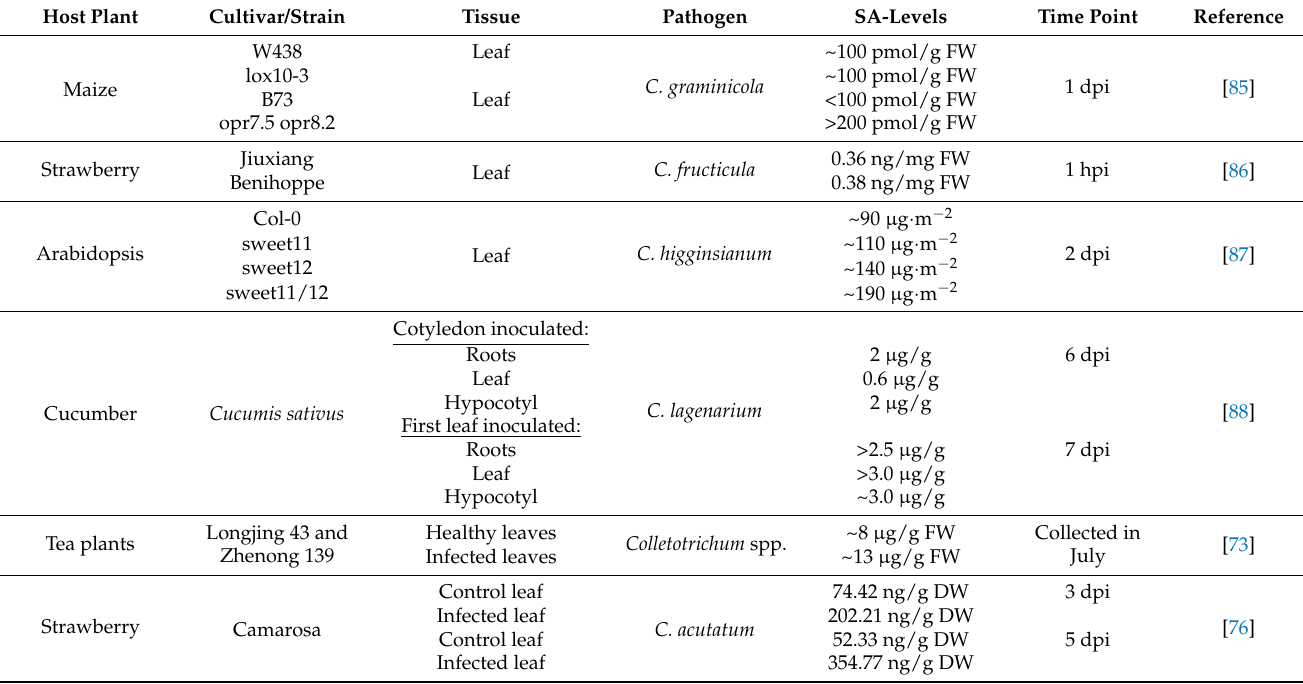
Table 1. Salicylic acid levels in different plants upon Colletotrichum